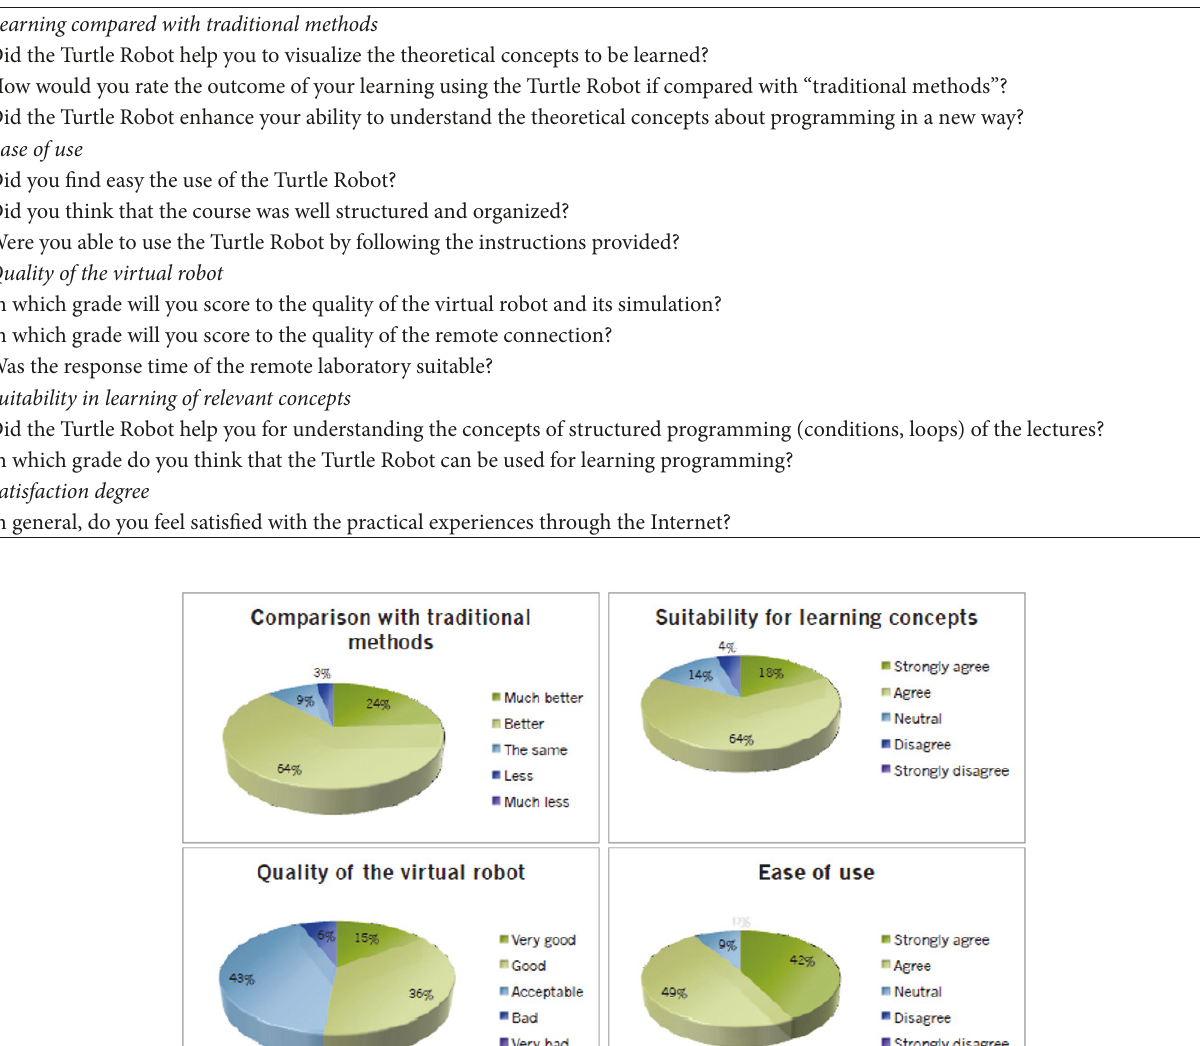
Table 2: Students’ questionnaire feedback for the Turtle Robot course. The answers are in a scale from one to five: “strongly agree,” “agree,” “neutral,” “disagree,” and “strongly disagree.”